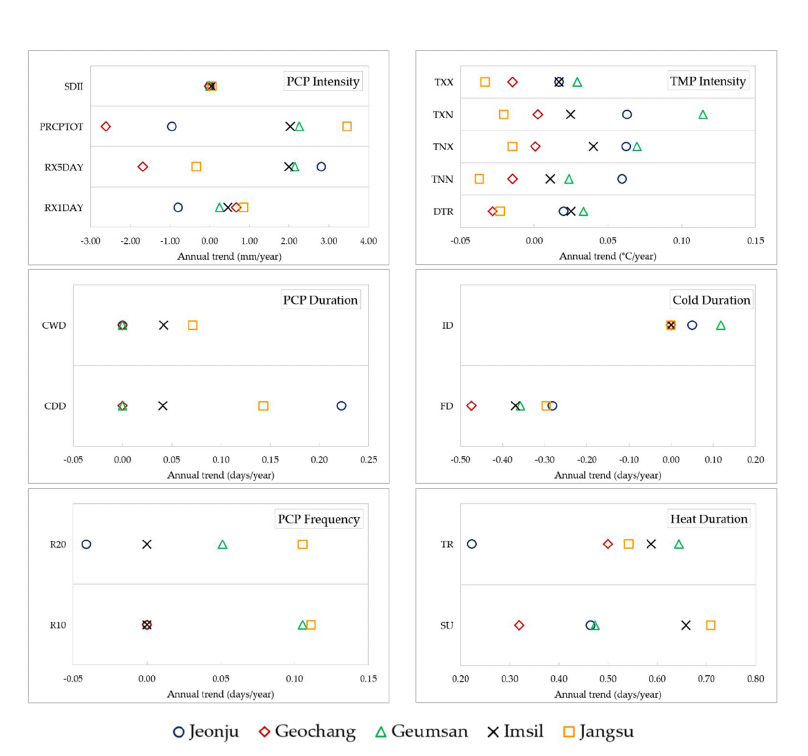
Figure A1. The magnitude of annual trends for both precipitation (left column) and temperature (right column) indices at the UGRB.